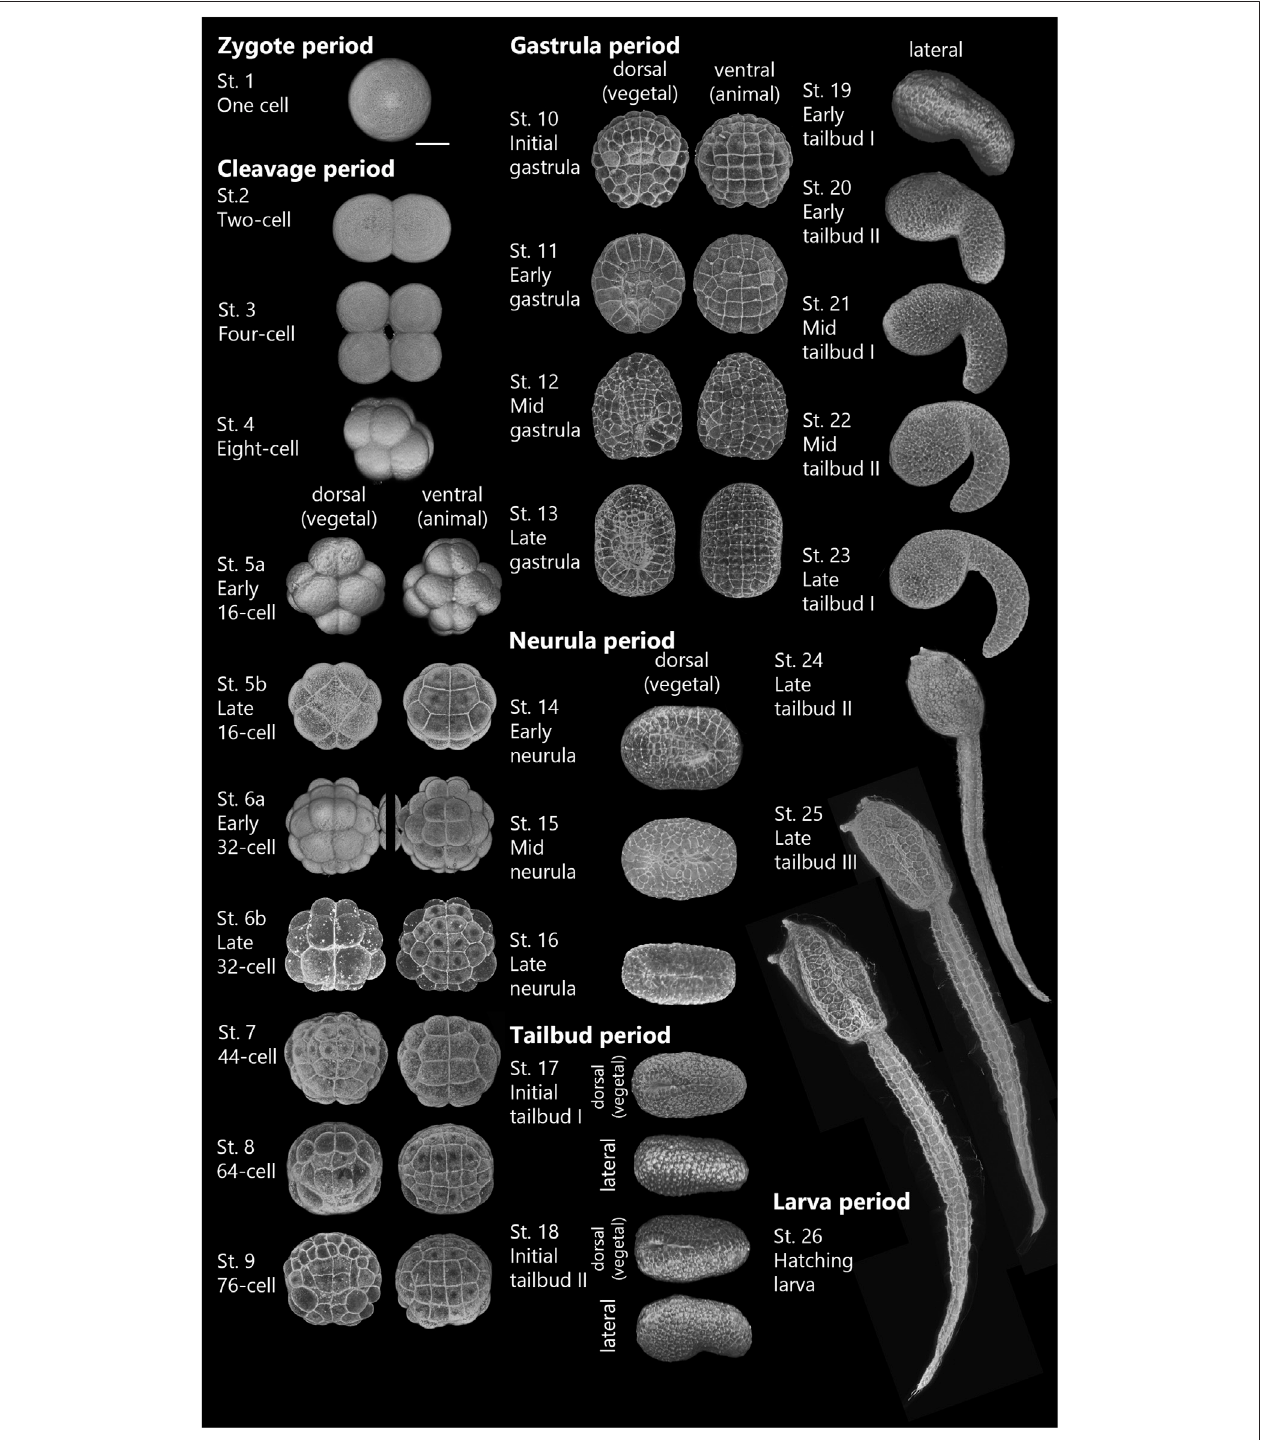
FIGURE 1 | Three-dimensional reconstructed images of the Ascidiella aspersa embryo in the developmental time course after fertilization. Fertilized eggs were dechorionated and incubated at 20 ° C. Embryos were stained with Alexa Fluor ™ 546 Phalloidin. In Stages 1 – 13, the anterior side of each embryo is up, and the anterior side is on the left in Stages 14 – 26. Stage 1 is in the zygote period. Stages 2 – 9 are in the cleavage period. Stages 10 – 13 are in the gastrula period. Stages 14 – 16 are in neurula period. Stages 17 – 25 are in the tailbud period. Stage 26 is in larva period. See the criteria for each stage in Table 1 . Scale bar: 50 μ m.